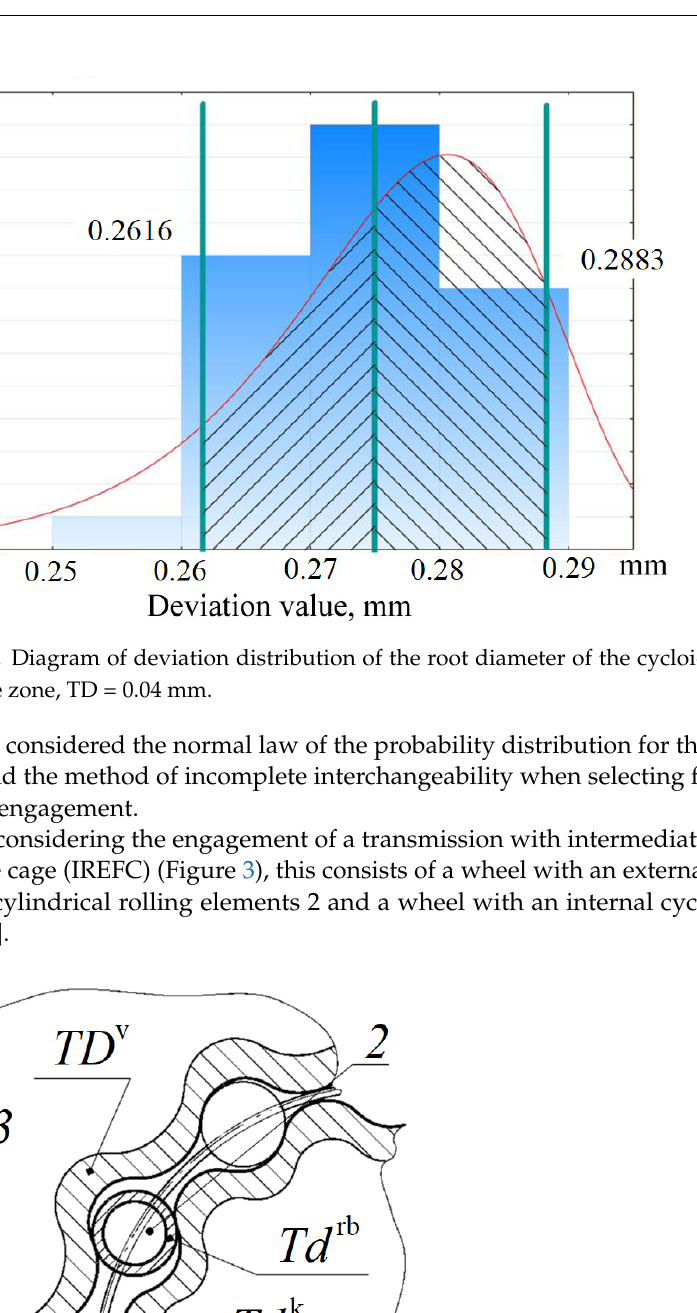
Figure 3. Engagement of a transmission with IREFC and tolerance zones of dimensions of link con- tacting surfaces: 1—cam; 2—intermediate rolling elements; 3—ring.